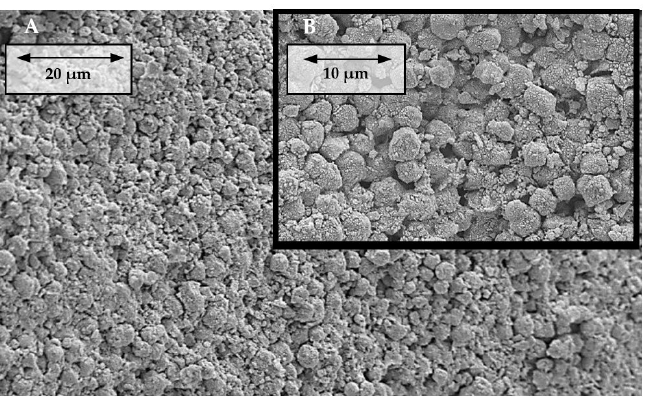
Processes 2022 , 10 , x FOR PEER REVIEW